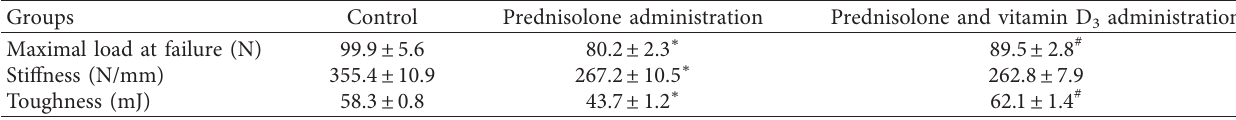
� 7). 3 administration, M ± m ( n